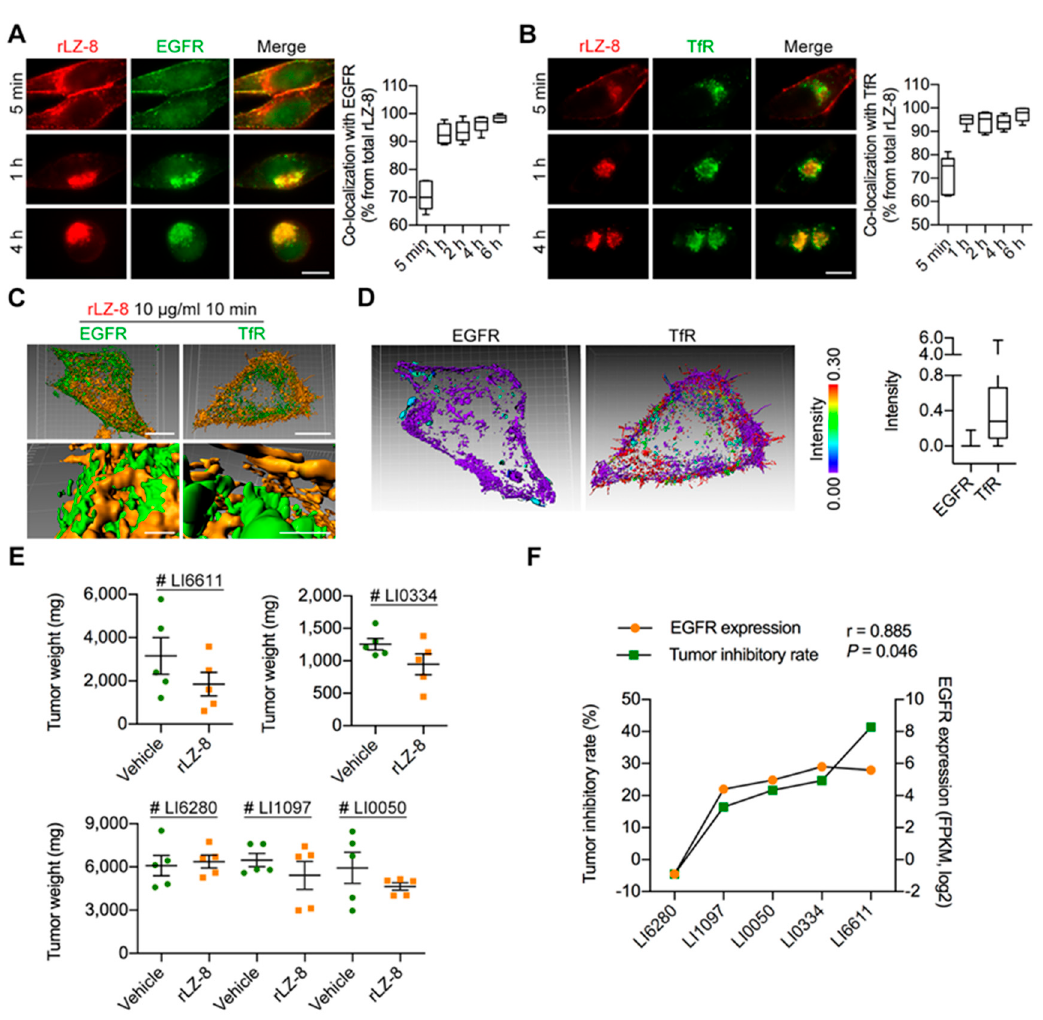
Figure 3. Epidermal growth factor receptor (EGFR) was the primary onco-target of rLZ-8. ( A,B ) Immunofluorescent staining of EGFR or trasnferrin (TfR) after 10 μ g/mL rLZ-8 treated on Hep3B cells. Co-localization was analyzed by Imaris. Scale bars, 10 μ m. ( C ) Hep3B cells were treated with rLZ-8, with EGFR/TfR coloring by immunofluorescence (no permeabilized). Surface rendering was generated from Imaris. Scale bars in above, 10 μ m; in below, 1 μ m. ( D ) Distance from rLZ-8 to the nearest EGFR/TfR was measured by Imaris. The varying distance transformed the intensity of fluorescence. ( E,F ) Different types of PDX models (LI6280, LI1097, LI0050, LI0334, LI6611) of HCC were established as shown in Materials and Methods. Mice were divided into groups and dosed with normal saline control or 5 mg/kg rLZ-8. All mice were injected once daily for total 28 days. ( E ) Tumors were dissected at 28 d post inoculation and imaged. Tumor weights were measured after dissection. ( F ) The correlation analysis between EGFR expression and tumor inhibitory rate. Pearson correlation coefficients. P -value and r-value as shown in panel. All data are means ± SD.